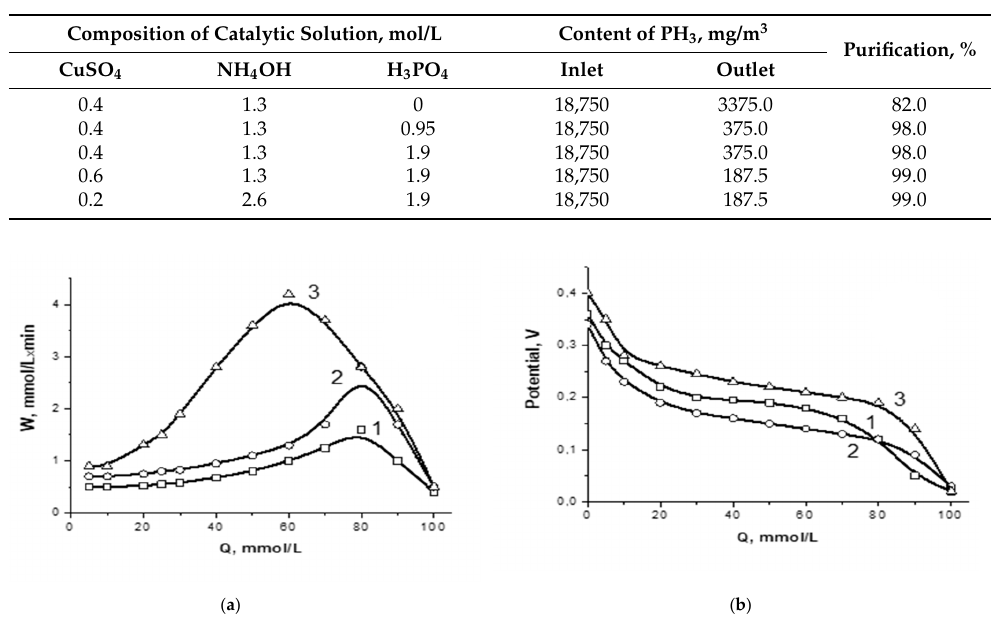
Figure 2. Kinetic ( a ) and potentiometric ( b ) curves of PH 3 oxidation by aqueous copper–ammonia complexes at C РН 3in = 10,000 mg/ m 3 , t = 50 °C, X(PH 3 ) = 98–99%; solution composition, mol/L: CuSO 4 —0.4; NH 4 OH—1.3; H 3 PO 4 : 0 (1), 0.95 (2), 1.9